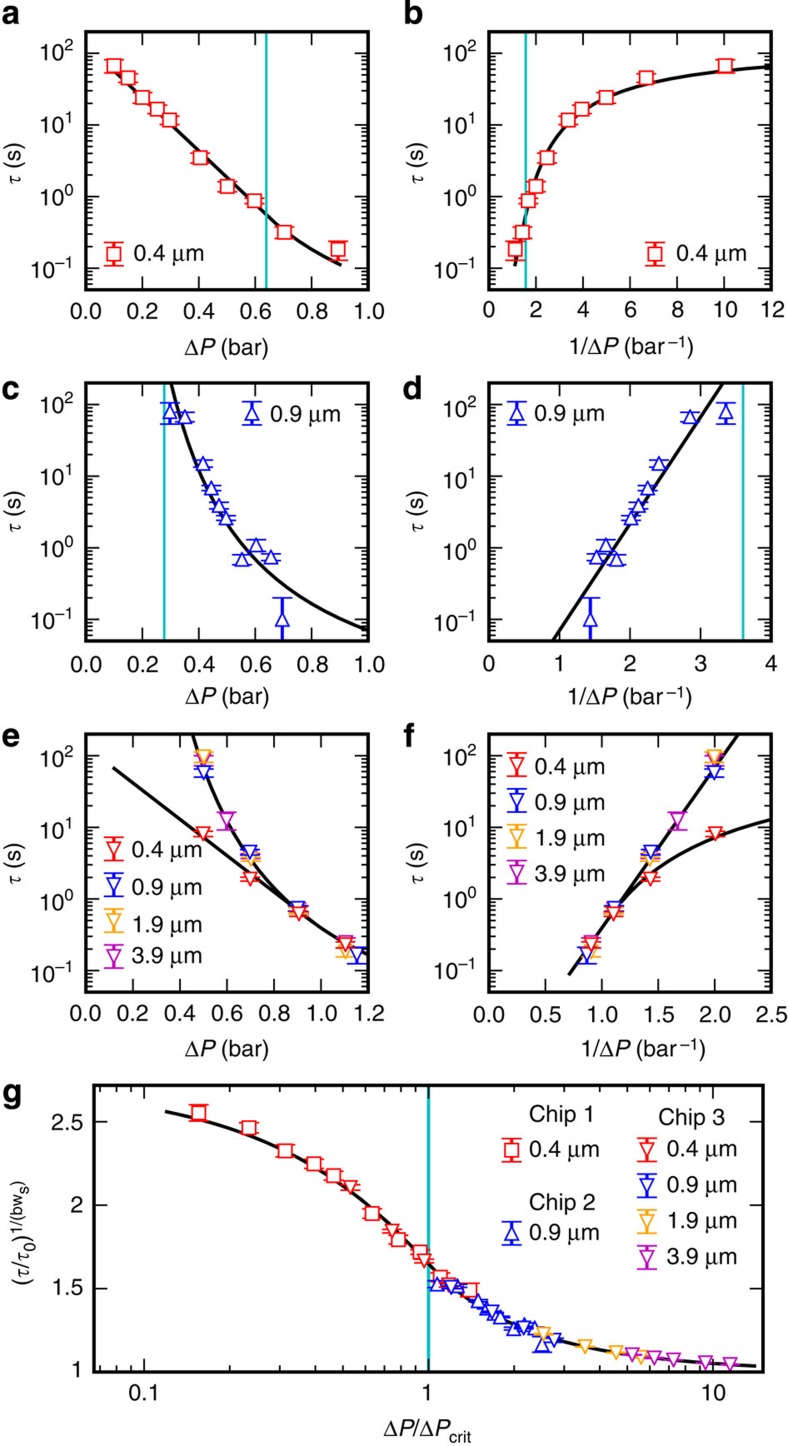
Average lifetimes of quasi-stationary states in various force fields.Experimentally measured average residence times τ of DNA strands
in a nanogroove as function of the pressure drop ΔP over the
microfluidic chip. Different symbols correspond to different chips,
different colors correspond to different nanoslit widths, see legends; chip
3 has different nanoslit widths at different places and hence does several
distinct experiments all on the same chip. Data were collected for three
different chips: (a,b) chip 1 (642 transition events),
(c,d) chip 2 (1,604 events) and (e,f) chip 3
(2,873 events). (a,c,e) τ as function of
ΔP—data follow a straight line for
ΔP<ΔPcrit and a hyperbolic curve
for ΔP>ΔPcrit;
(b,d,f) τ as function of
1/ΔP—data follow a straight line for
1/ΔP<1/ΔPcrit and a hyperbolic
curve for 1/ΔP>1/ΔPcrit. Symbols:
experimental data, mean±s.e.m. (examples of full distributions are
shown in Fig. 4 and Supplementary Fig. 1); black lines:
single fit of the theory (equation (2)) to all data in
a–f (see Methods section); blue vertical lines:
ΔPcrit for a,c,e,
1/ΔPcrit for b,d,f.
(g) All data from the three microfluidic chips fall on a single
curve given by equation (3), independent of chip
geometry when expressed in dimensionless variables
ΔP/ΔPcrit and .